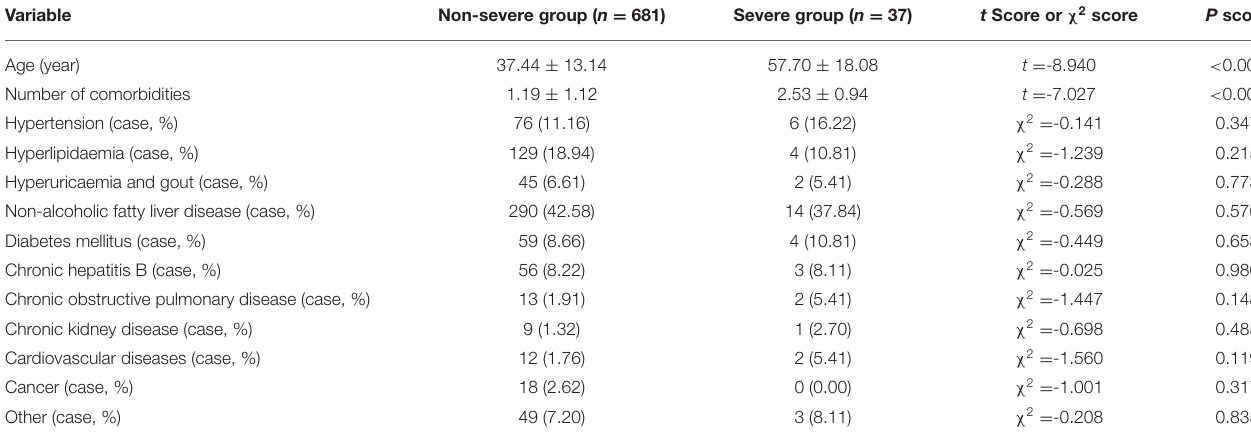
TABLE 2 | Comparison of age and comorbidities between the non-severe group and the severe group ( n = 718). Variable Non-severe group ( n =